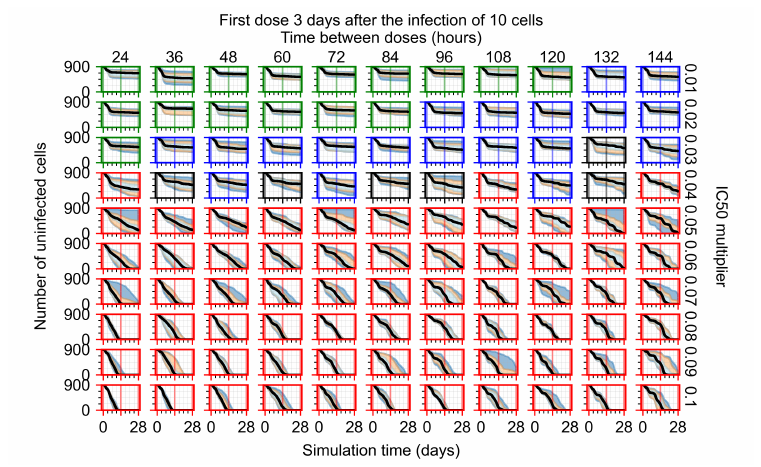
Figure A100. Uninfected